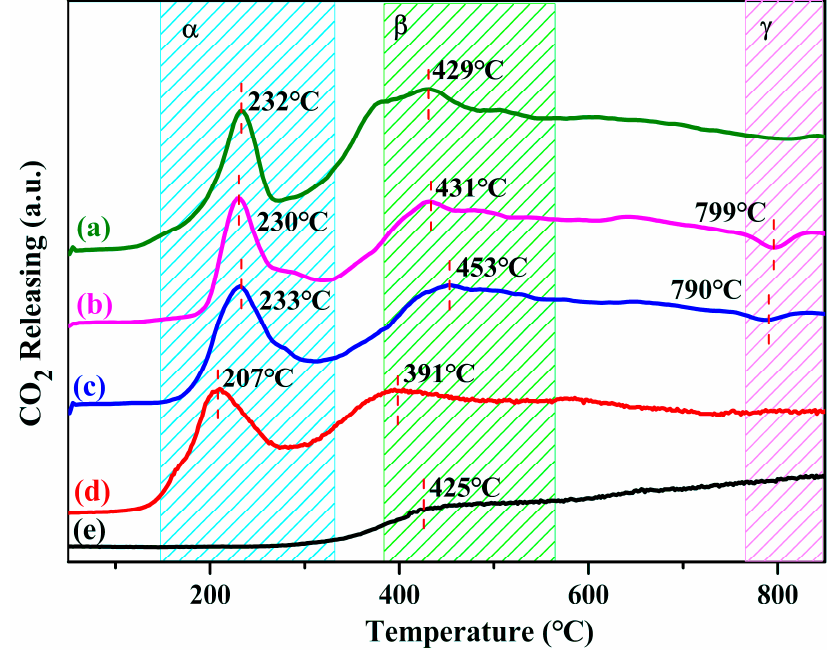
Figure 8. CO temperature programmed reduction (CO-TPR) profiles of PdAg/Z catalysts calcined at different temperatures. ( a ) PdAg/Z-850; ( b ) PdAg/Z-700; ( c ) PdAg/Z-600; ( d ) PdAg/Z-500, and ( e ) support.